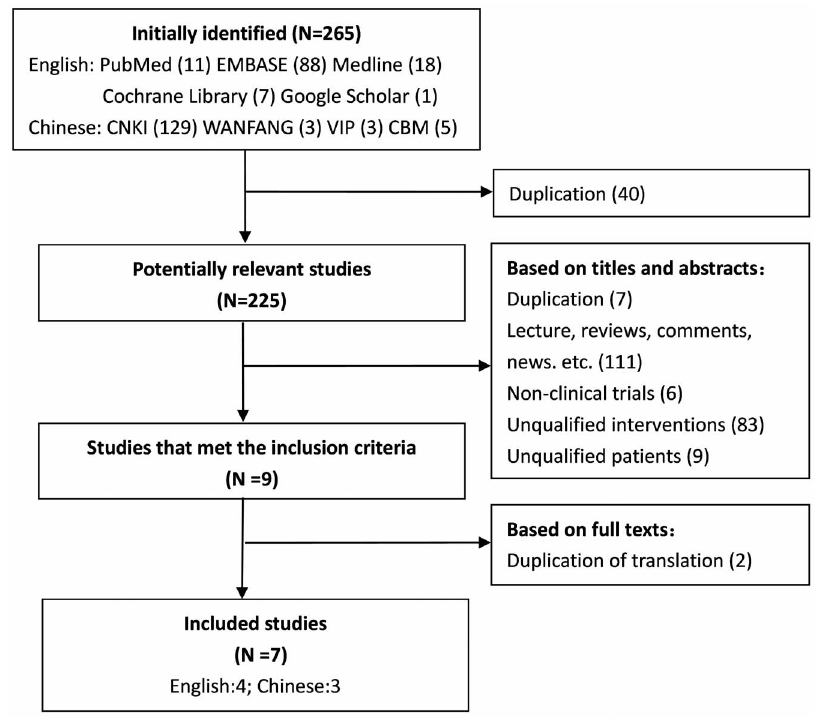
Figure 1. Flow diagram of the results of the search strategy.